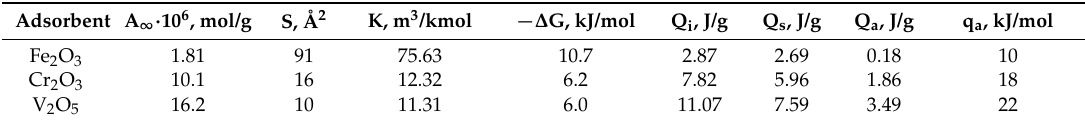
Table 1. Physicochemical parameters of BP adsorption on surfaces of Fe 2 O 3 , Cr 2 O 3 and V 2 O 5 from styrene at 303 K.